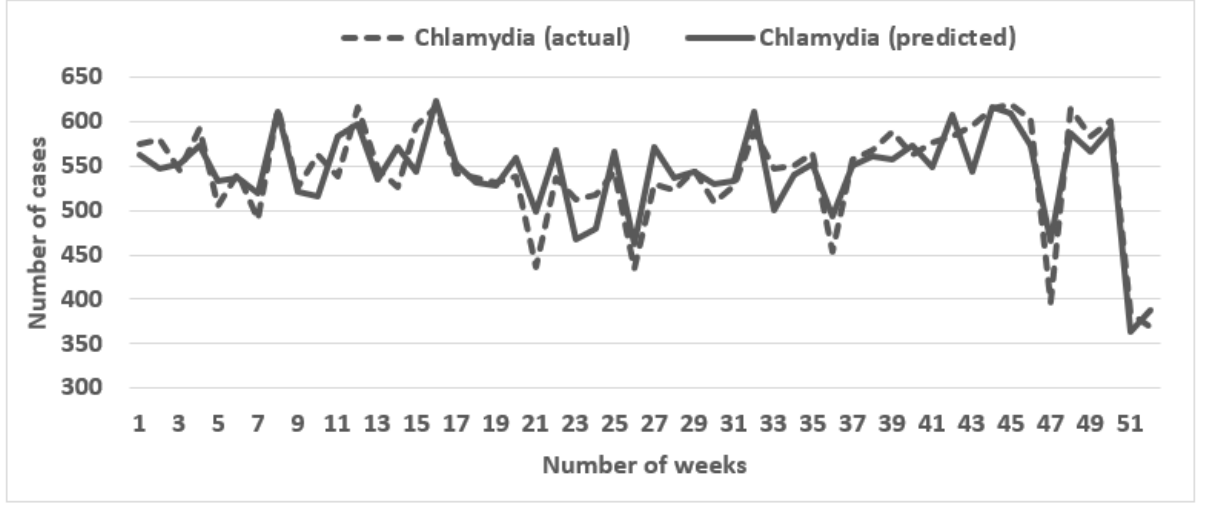
Figure 2. Graphical comparison between the actual and predicted number of chlamydia cases for 2017.